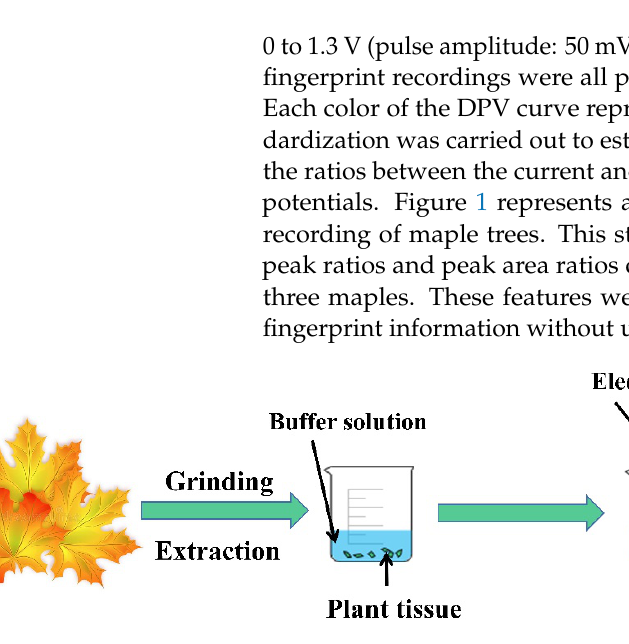
Figure 1. Schematic diagram of the electrochemical fingerprint recording of Acer spp.